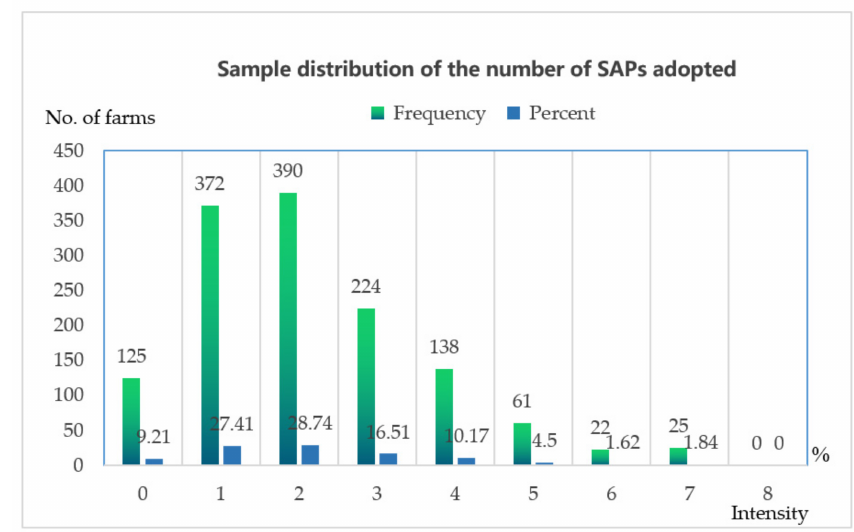
Figure 1. Sample distribution for SAPs adoption.